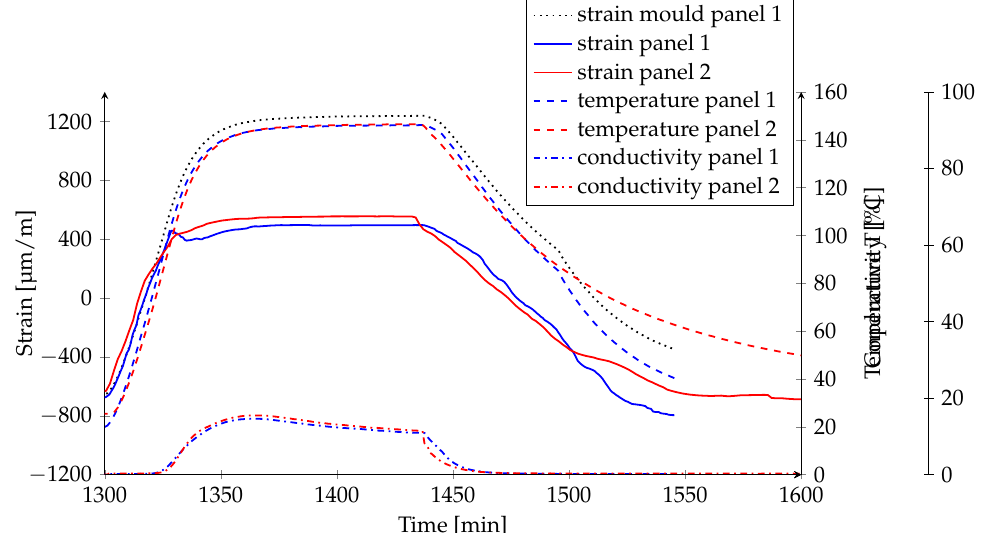
Figure 5. Measured laminate strains, temperatures, conductivities and calculated mould strain of the post-curing step of panel 1 and panel